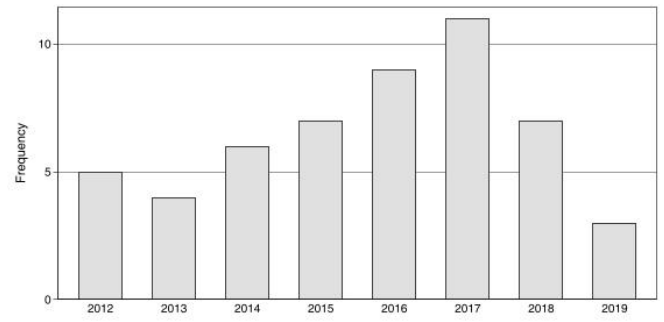
Figure 3. Number of forest property sales in the study areas from 2012 to 2019. Source: own elaboration.